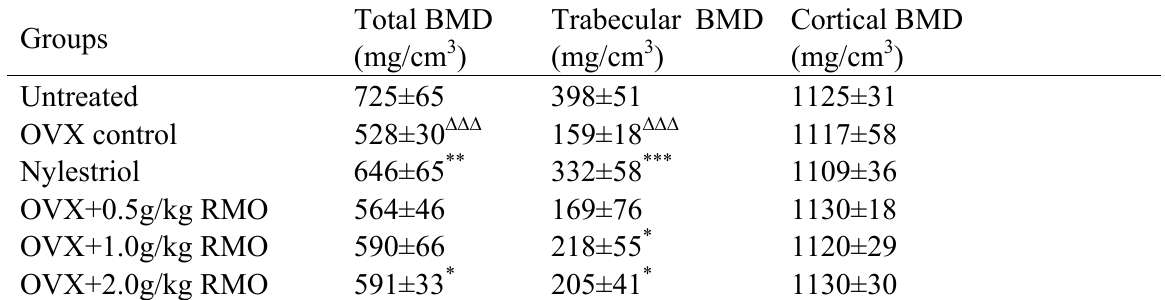
Table 3. Effects of RMO on bone mineral density (BMD) in OVX rats